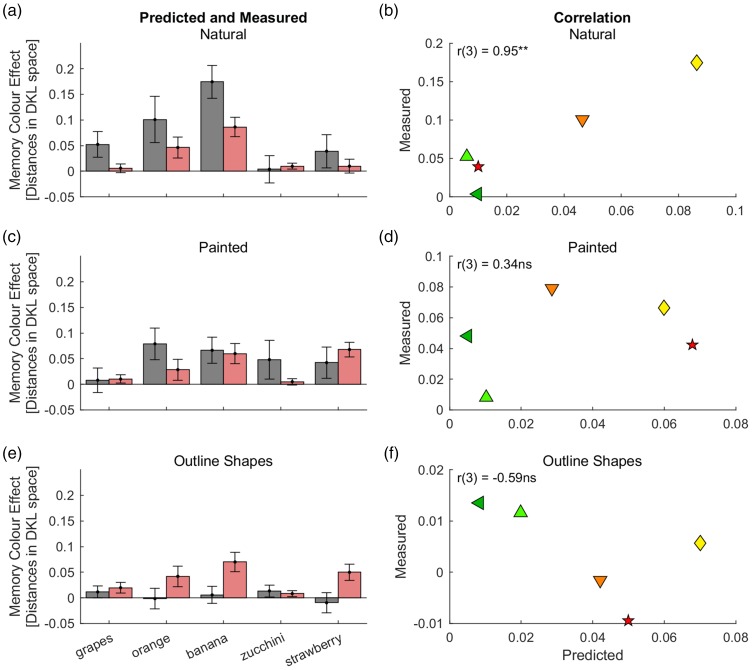
Predictions for aggregated data of Experiment 1b of Olkkonen et al. (2008). Rows illustrate results with photographs of original objects (a and b), photographs of white-painted objects (c and d) and outline shapes (e and f). Format is as shown in Figure 3. The grey bars correspond to the bars in Figure 4(b) of Olkkonen et al. (2008), except for the difference between absolute and relative shifts (cf. Figure 3).